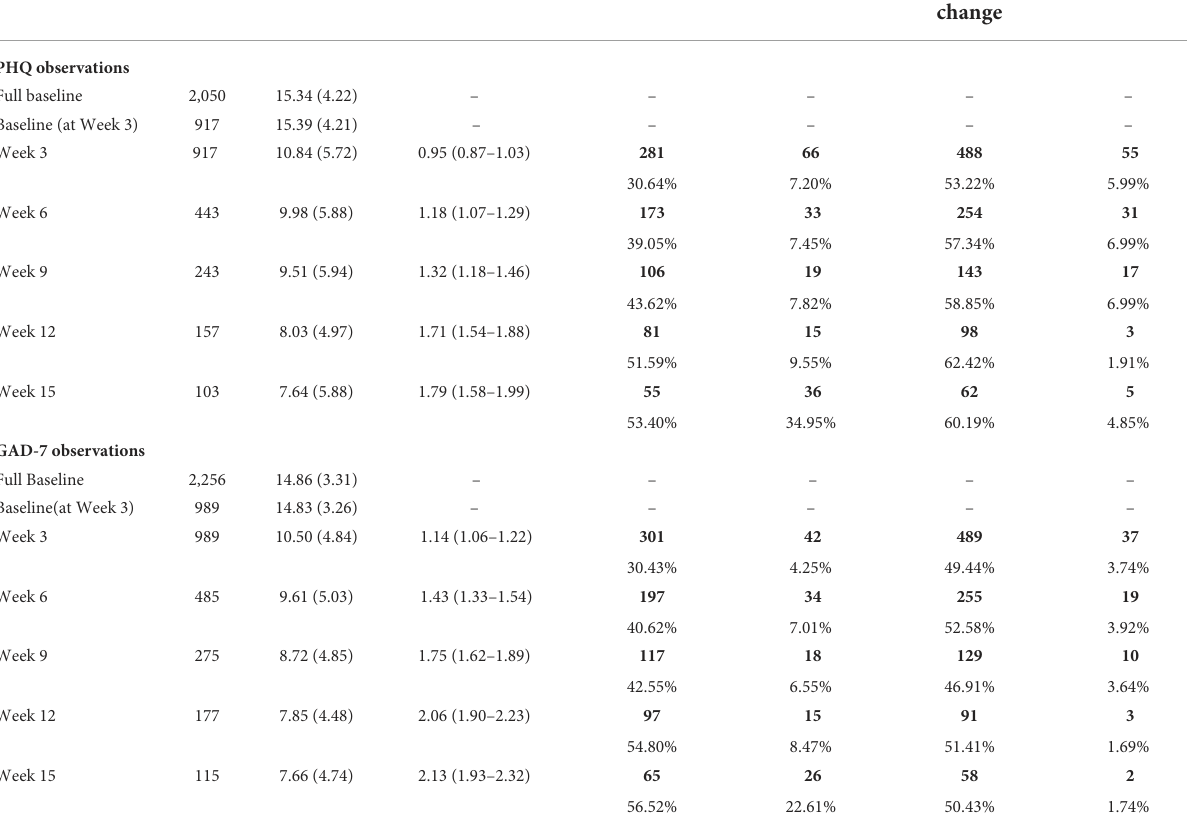
TABLE 3 Clinical outcomes for the matched sample ( N =